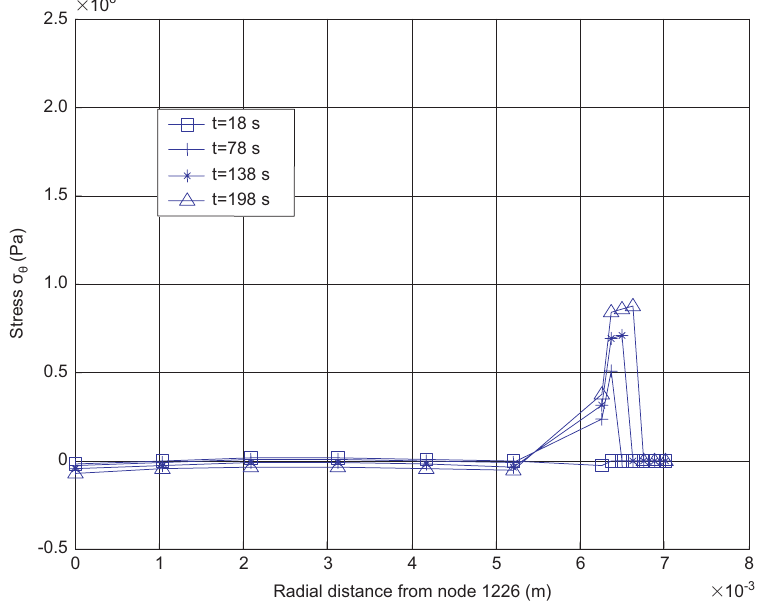
Figure 18 Hoop stresses along radial direction at angle 103.5 ° from node 1226 to 94 at rotation speed 1 rpm when the moving heater is over the spot (steel